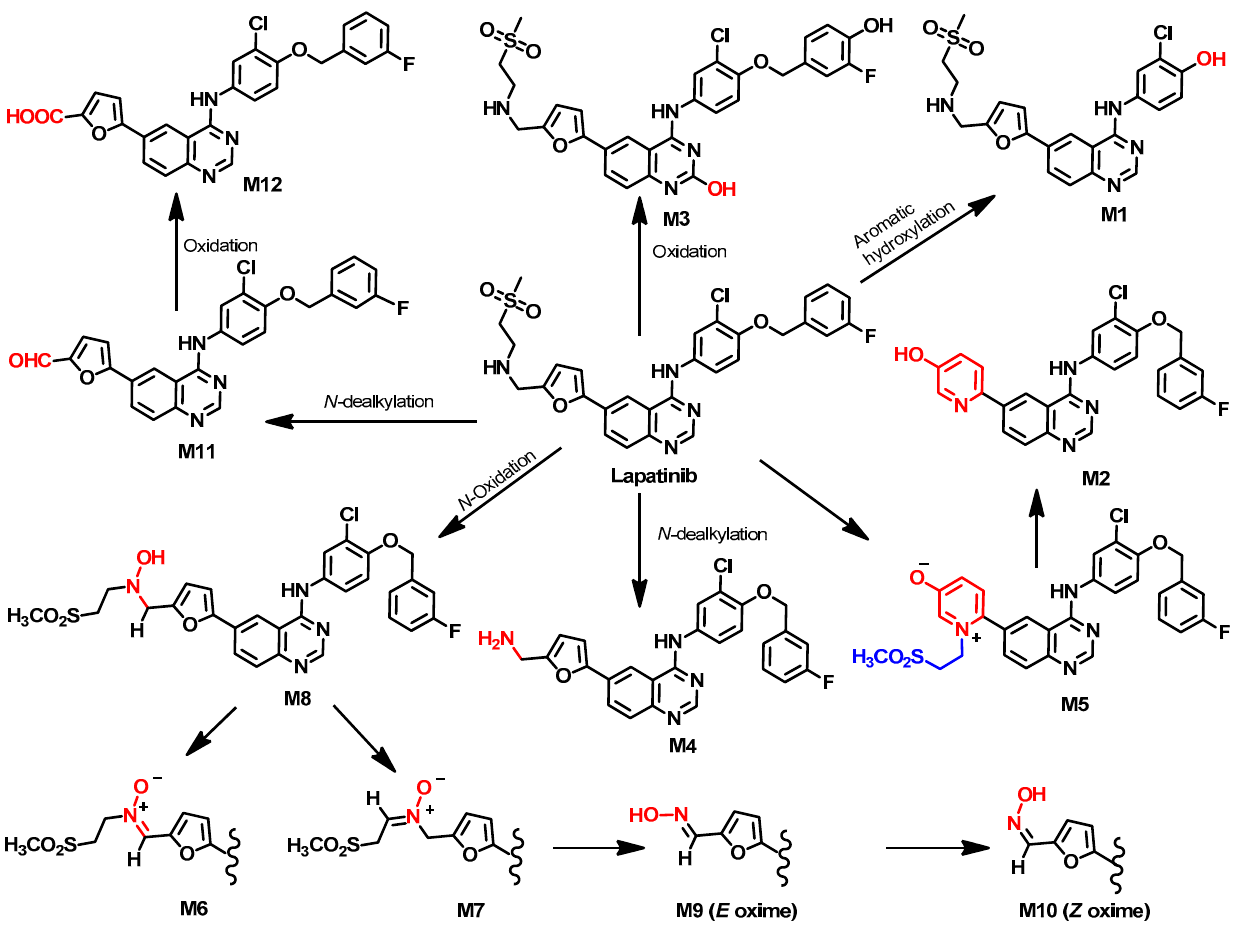
Figure 42. Proposed metabolic pathways of lapatinib.